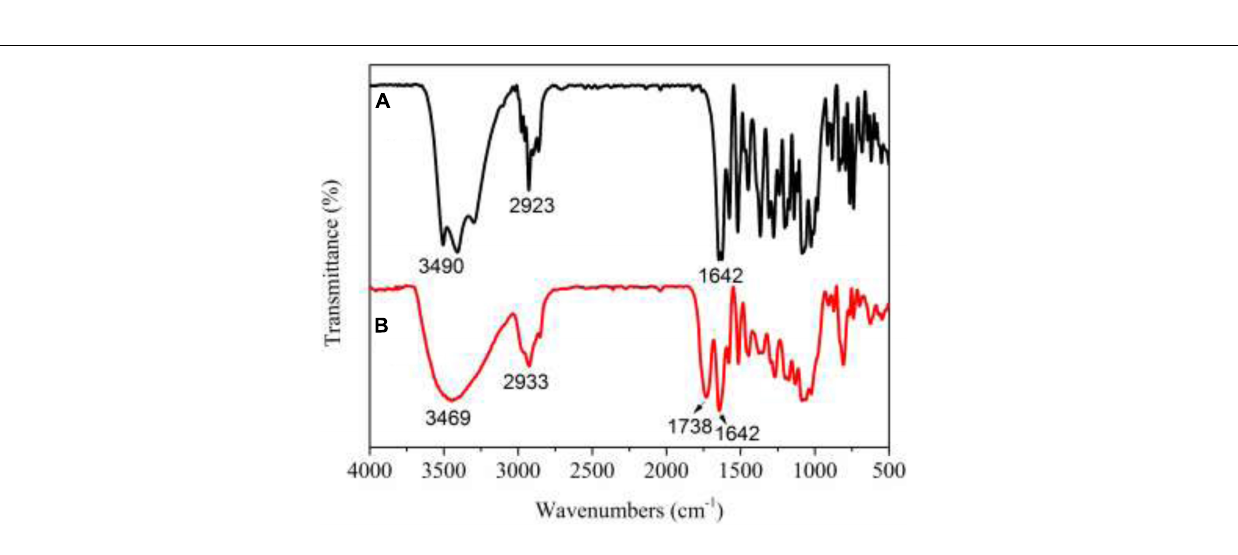
FIGURE 4 | FT-IR spectra of NH (A) and PNHE (B)